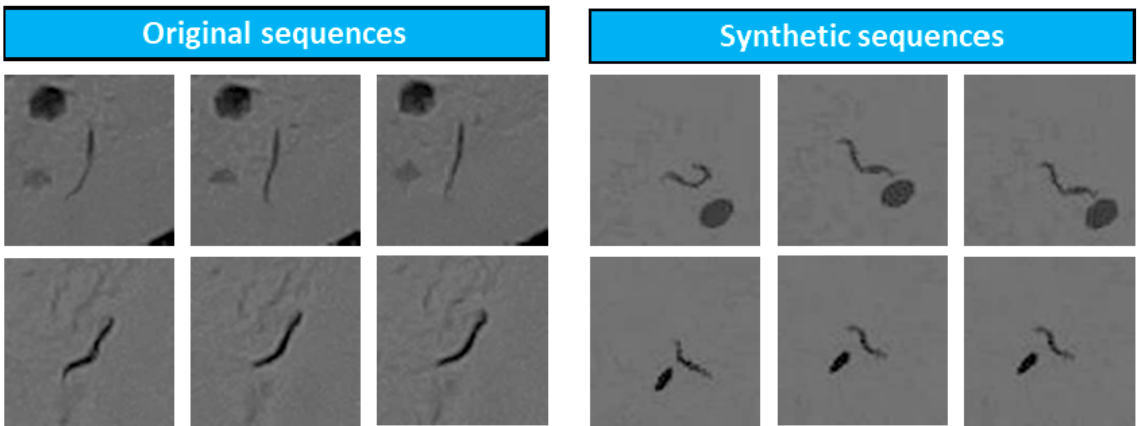
Figure 7. Two original image sequences are shown on the left and two sequences generated by the simulator are shown on the right.